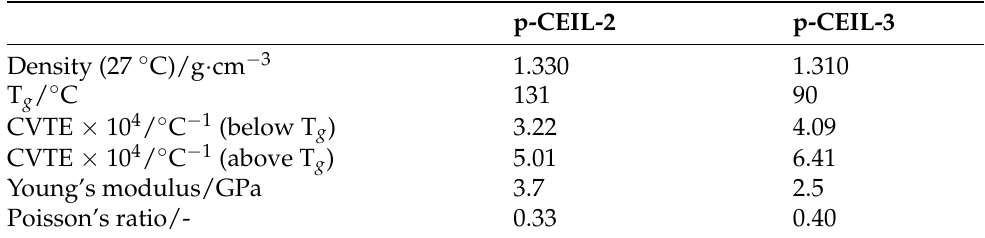
Table 2. Predicted properties of the polymerised samples (averaged over three independently generated